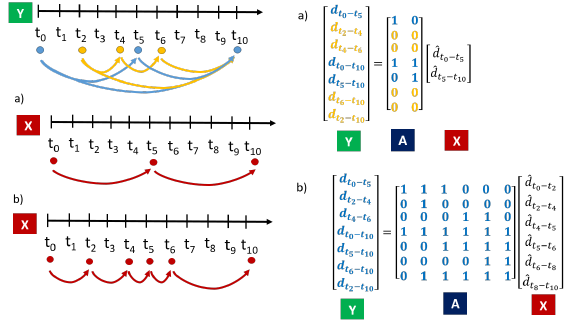
Figure 3. Illustration of the temporal closure of the displacement observation network used to obtain a) a regular LF time series. The temporal sampling corresponds to the Satellite 1 repeat cycle b) an Irregular LF time series. The vector Y corresponds to the displacement observations. The vector X stands for the LF displacement time series. A is the design matrix linked X and Y in the temporal